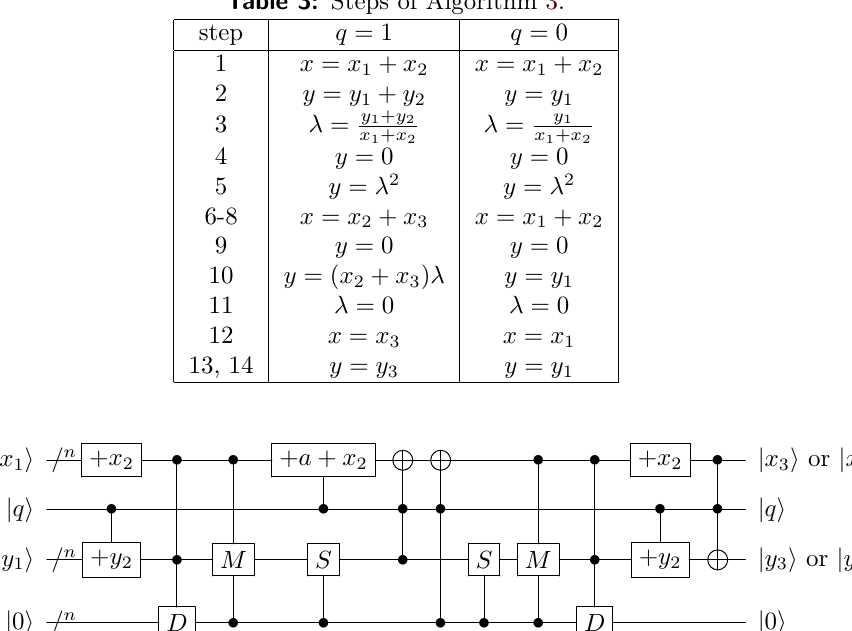
Table 3: Steps of Algorithm 3.